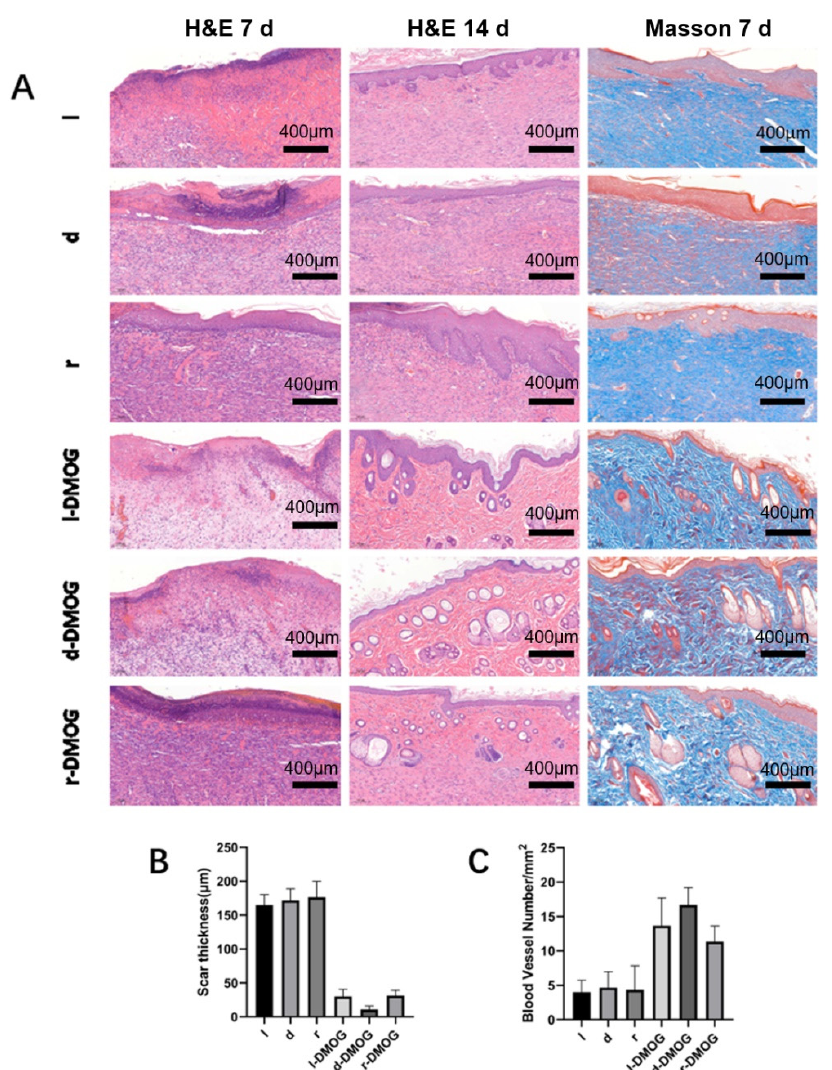
Figure 5. ( A ) H&E staining and Masson staining were performed on the wounds of different groups of rats; ( B ) the scar thickness was measured, and it was found that the hydrogel containing the drug group could significantly reduce the scar thickness; ( C ) counting the number of subcutaneous new blood vessels demonstrated that the hydrogel containing DMOG can significantly increase the content of new subcutaneous blood vessels. (Scale bar 400 μ m).